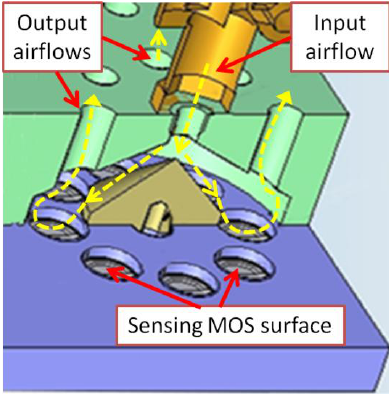
Figure 5. Approximate airflow scheme inside each